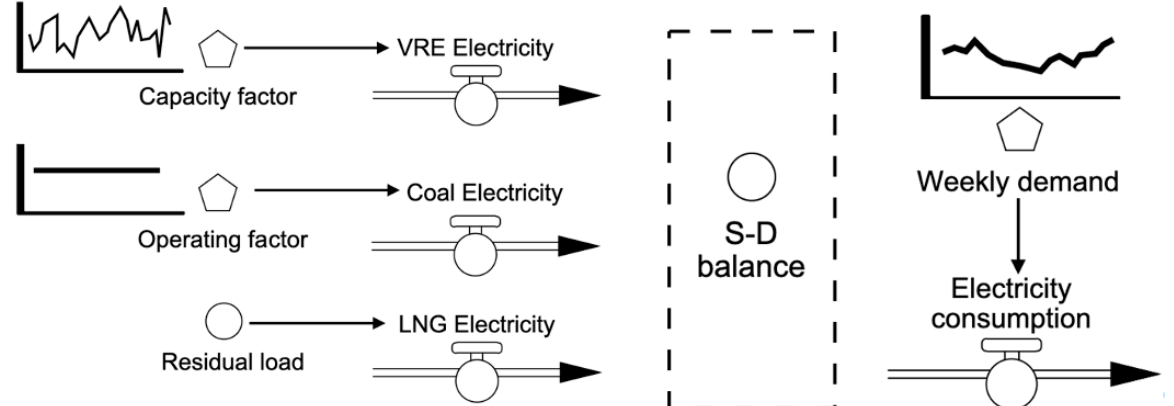
Figure 5. Stock-flow diagram of the balance of supply and demand.